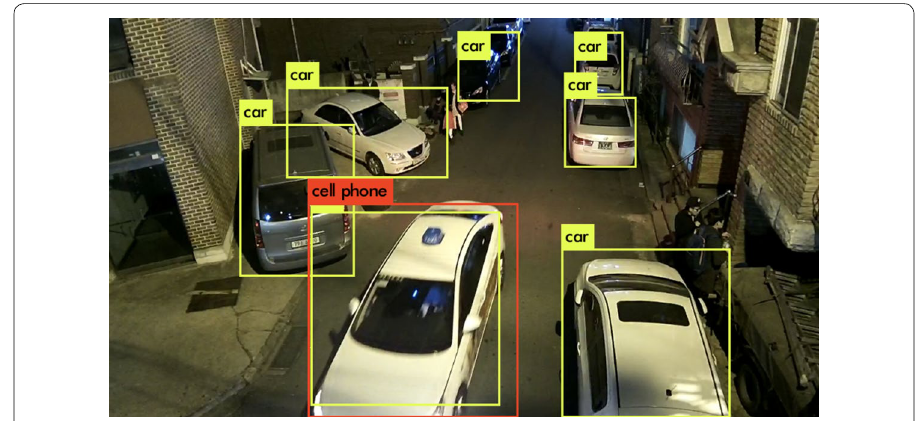
Fig. 1 Object detection with a pretrained YOLO